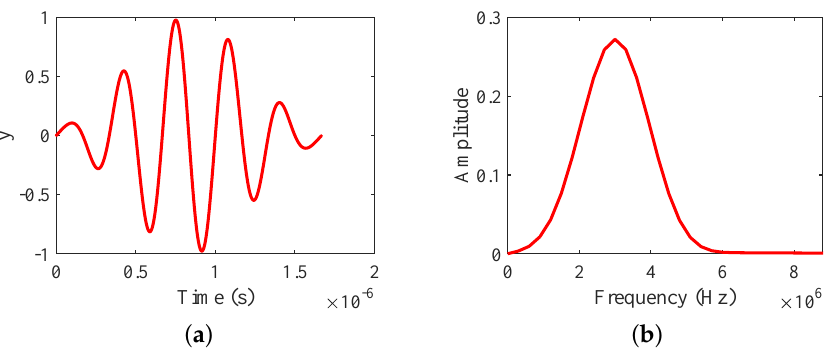
Figure 5. ( a ) Temporal waveform of the excited tone burst signal. ( b ) Frequency spectrum of the excited tone burst